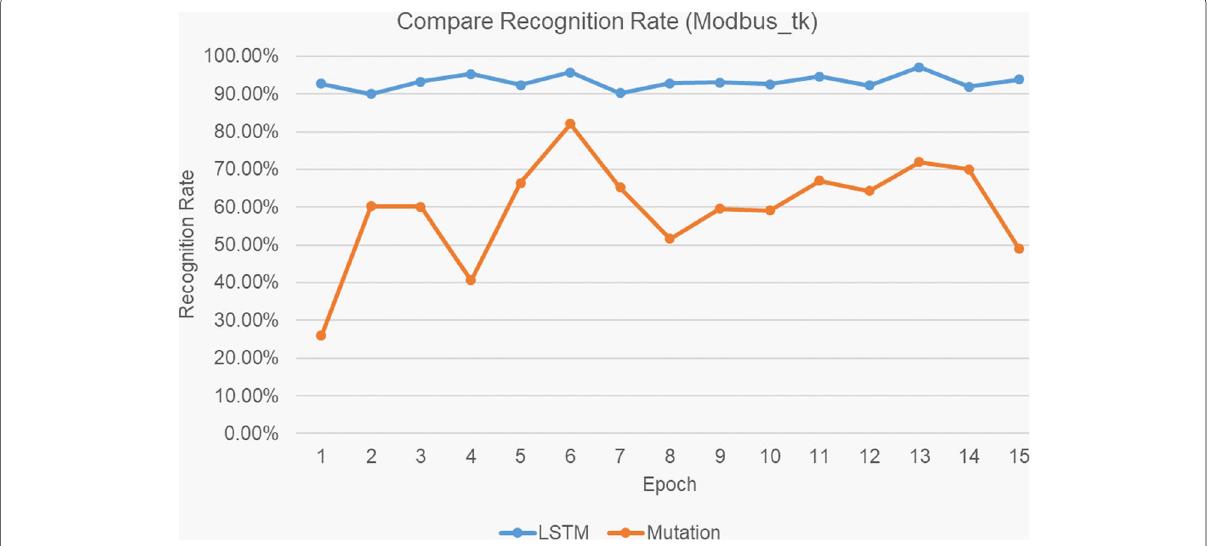
Fig. 12 The recognition rate of Modbus_tk. The recognition rate of the data predicted by LSTM and using Modbus_tk as the